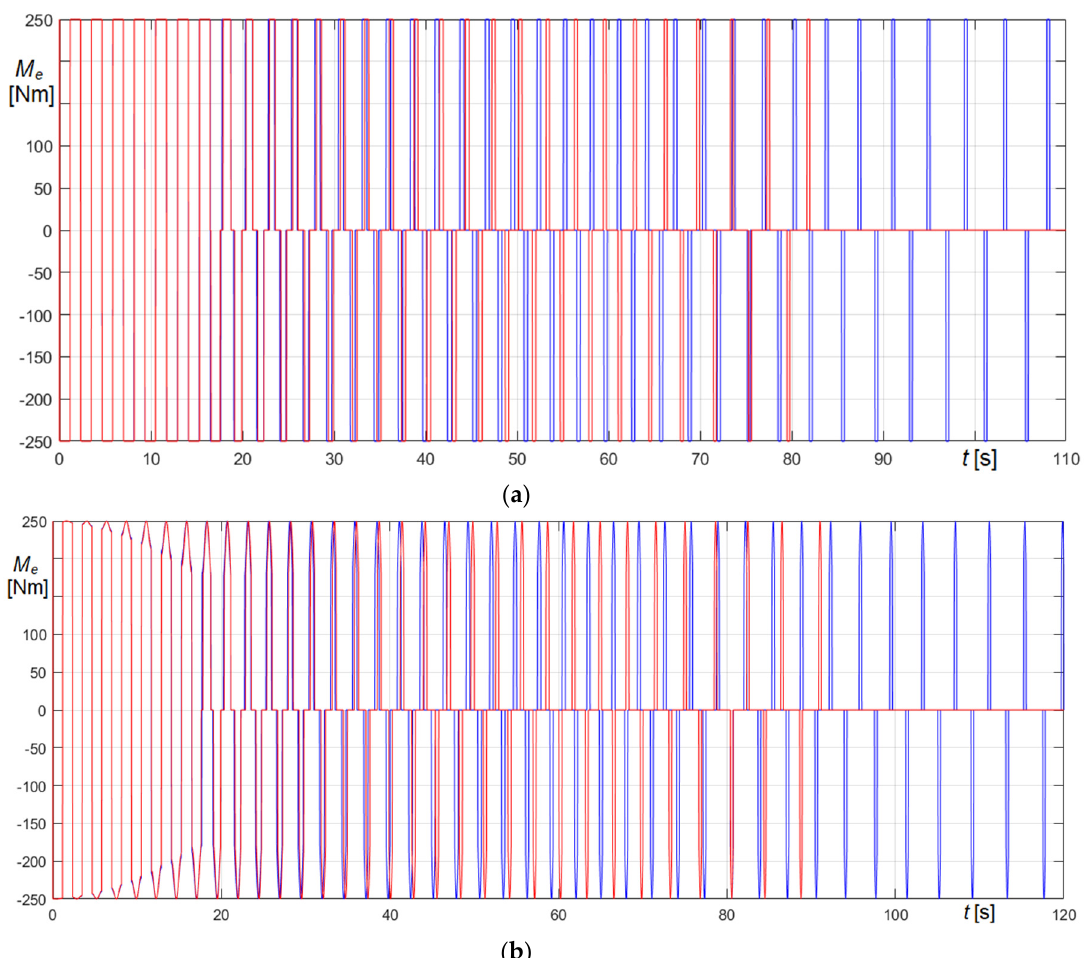
Figure 26. Comparison of the apparent period, (cid:1846) ∗ , maximum amplitude, (cid:2016) (cid:2923)(cid:2911)(cid:2934)∗ , curves of undamped (solid line) and damped (dashed line) forced oscillations.